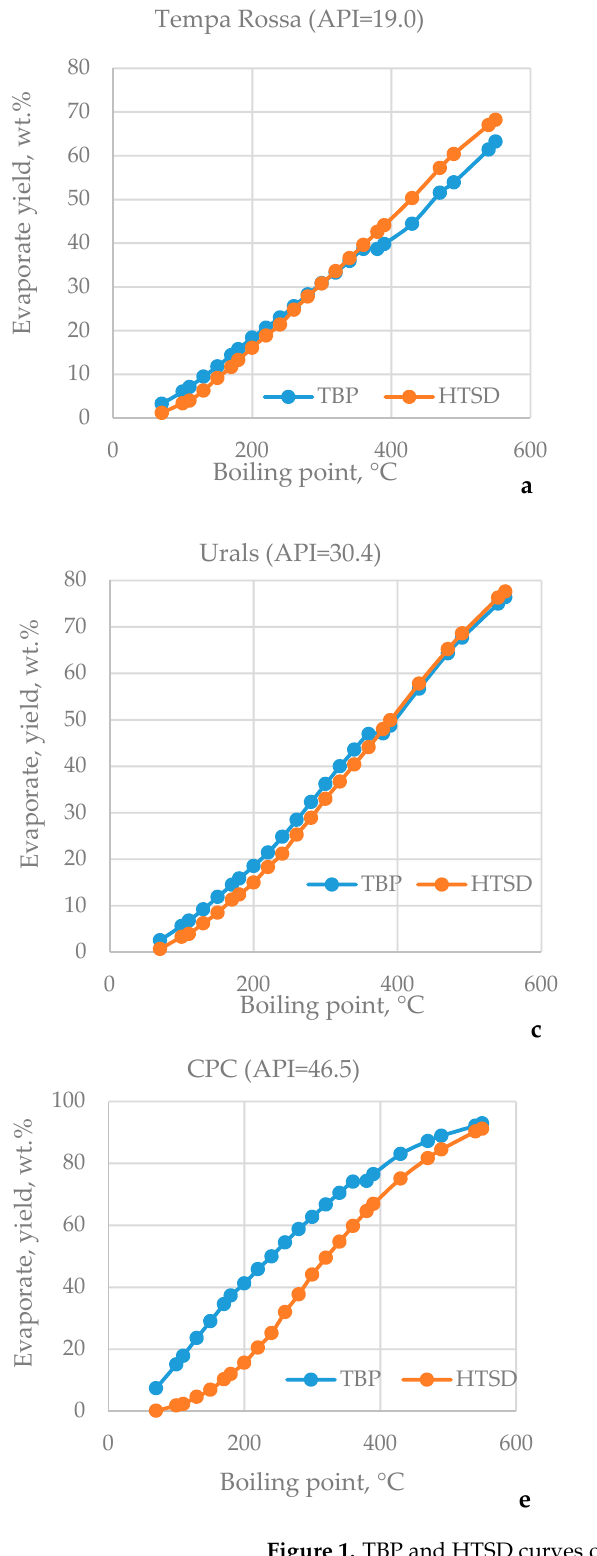
Figure 1. TBP and HTSD curves of extra light ( d , e ), light ( f ), medium ( b , c ), and heavy ( a ) crude oils. Crude oil specific gravity and HTSD data for the 110–180 ◦ C; 180–240 ◦ C; 240–360 ◦ C; IBP—360 ◦ C; IBP—540 ◦ C; and T 50% fractions were employed to develop conversion equations. With nonlinear regression and the computer algebra system Maple (and Global Op-